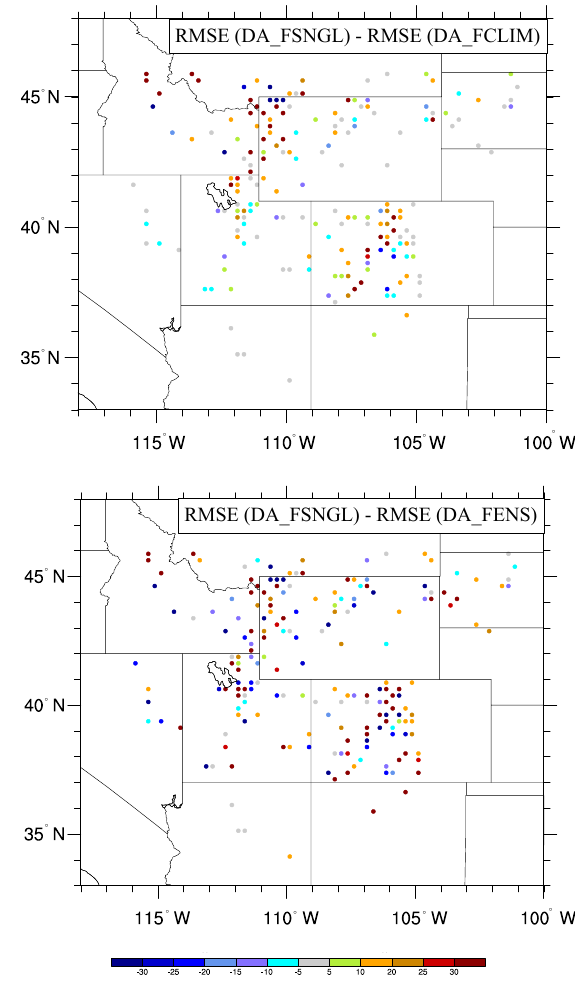
Figure 7. Same as Fig. 5, but for the Colorado headwaters